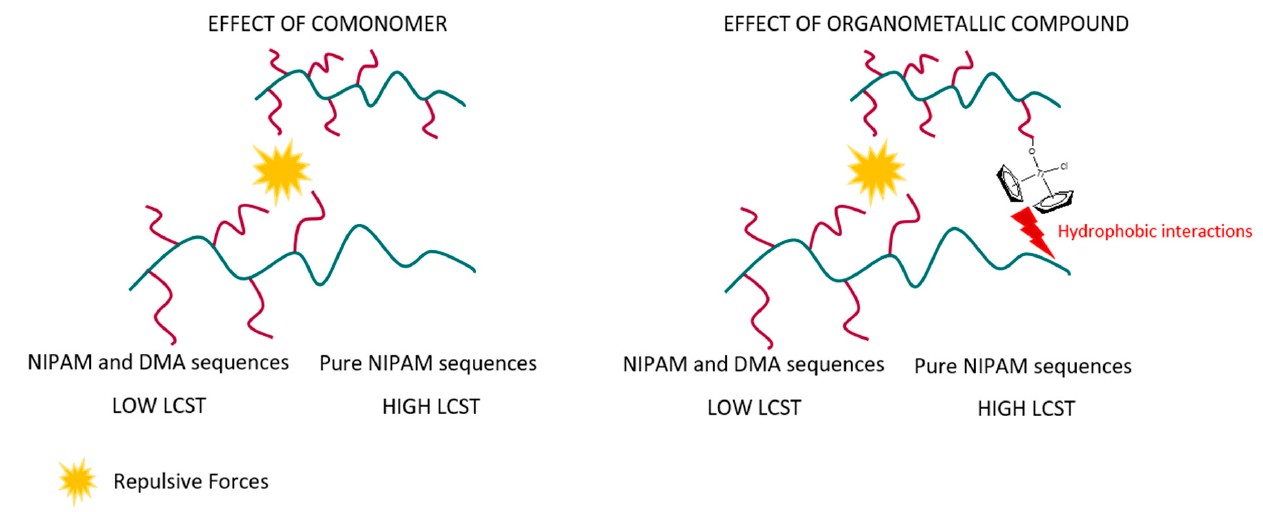
Scheme 2. Effect of hydrophobic groups over surrounding polymeric chains in solution.